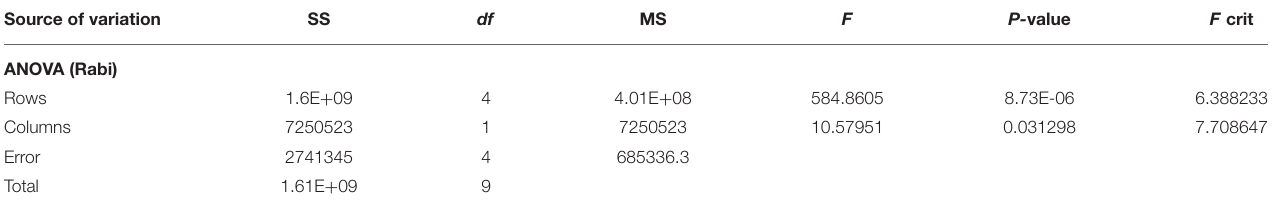
TABLE 16 | Statistical analysis of Rabi season from Table 17 . Source of